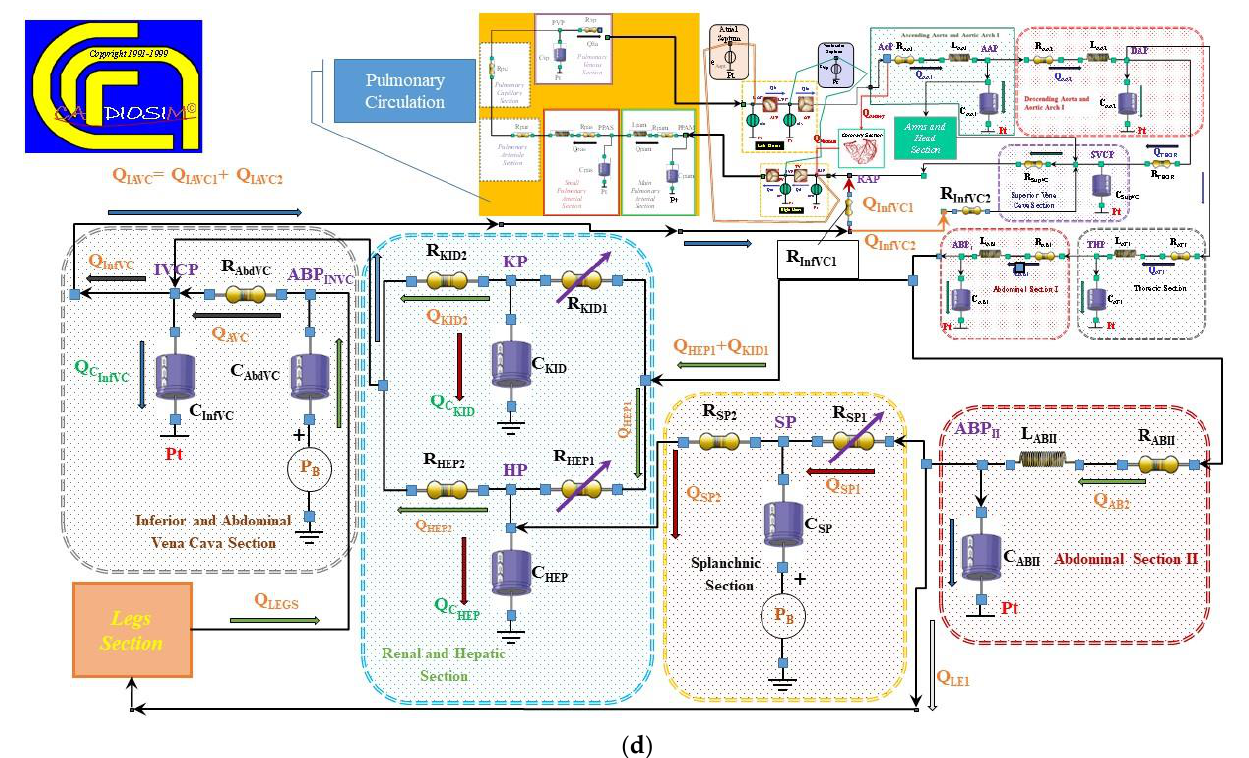
Figure 2. ( a ) Schematic representation of the cardiovascular system implemented in CARDIOSIM© software platform. ( b ) Electric analogue of the ascending and descending aorta, aortic arch, thoracic and abdominal sections and superior vena cava. ( c ) Electric analogue of the upper and lower limbs and the head. The six switches allow the activation of one of the four cannulation strategies. ( d ) Electric analogue of abdominal section (II), splanchnic, renal, hepatic, inferior and abdominal vena cava sections.